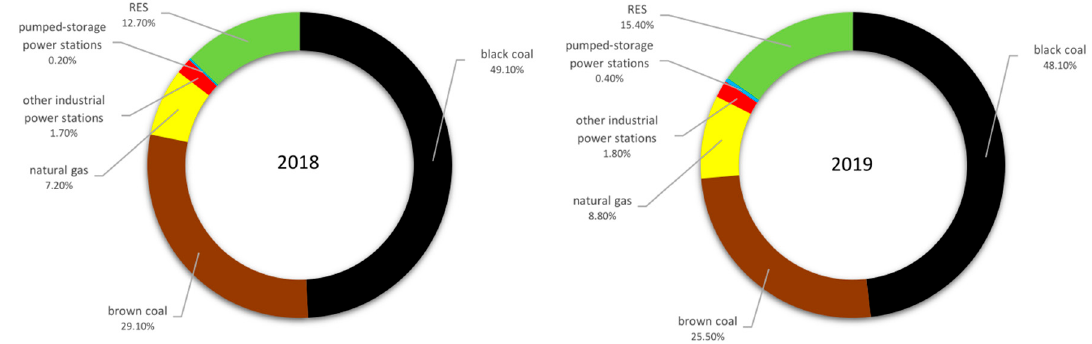
Figure 10. Breakdown of electricity production in Poland in the years 2018–2019 [%] (data from references [137,138]). Table 7. Annual economic flows for the years